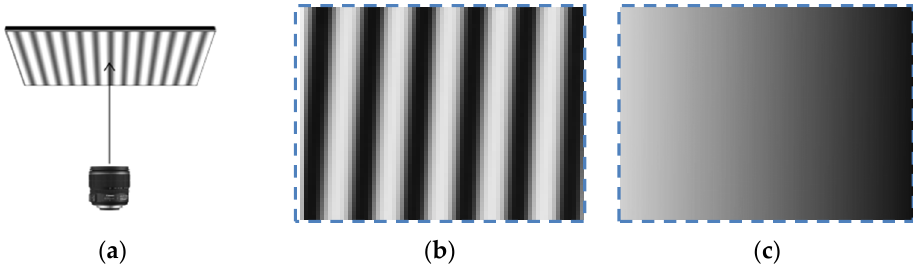
Figure 2. ( a ) The lens is parallel to the LCD; ( b ) captured fringe image; ( c ) sub-pixel encoding.